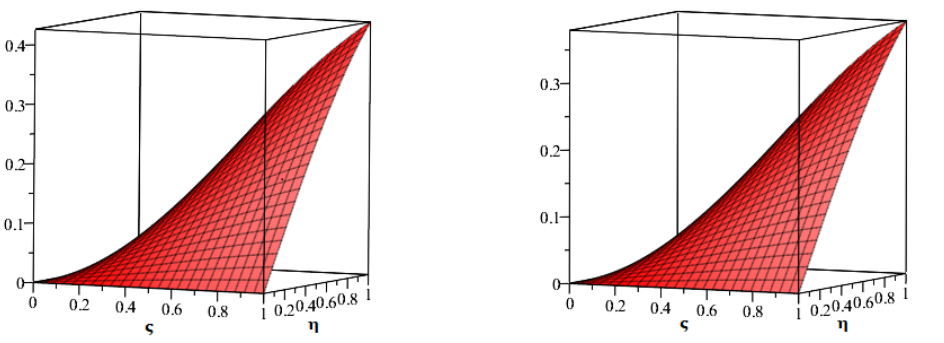
Figure 2. The proposed method solution at γ = 1.8,1.6 for example 1.